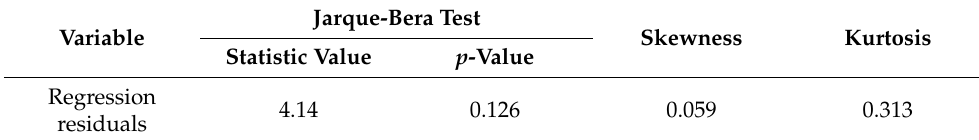
Table 3. Jarque–Bera normality test.